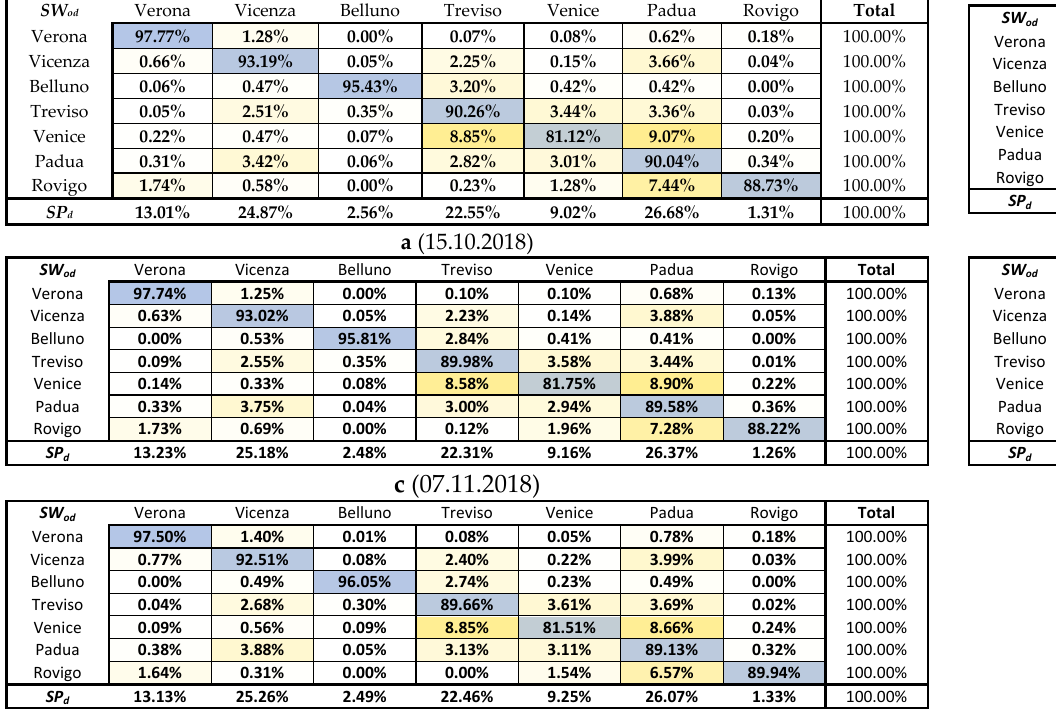
Figure 4. Shares of O-D flows between provinces of the Veneto region (sample-based).